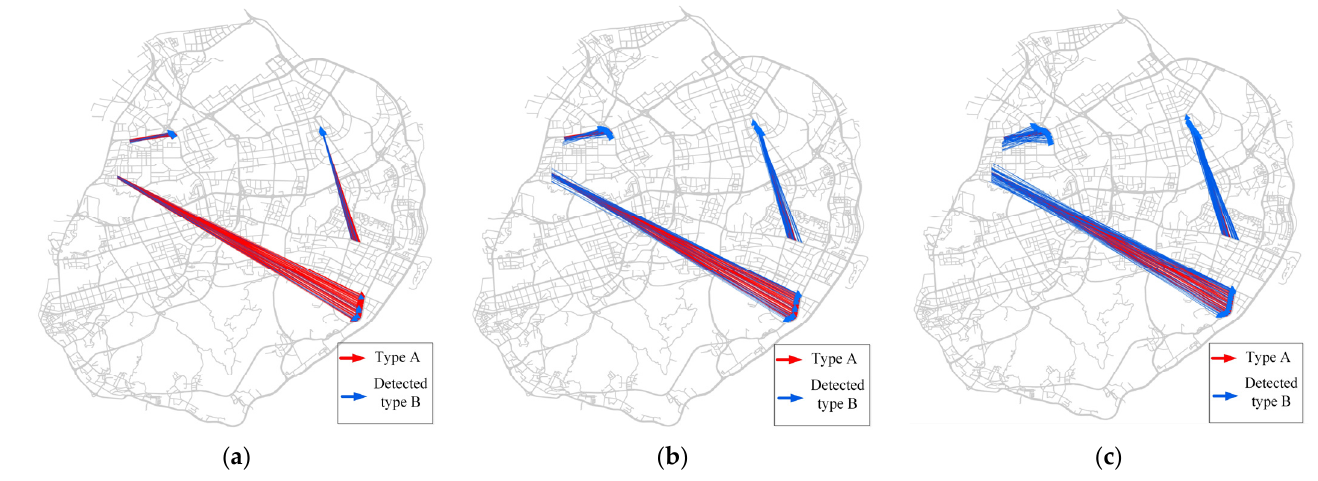
Figure 3. Results of simulated dataset 3: ( a ) 50 m; ( b ) 150 m; ( c ) 300 m.